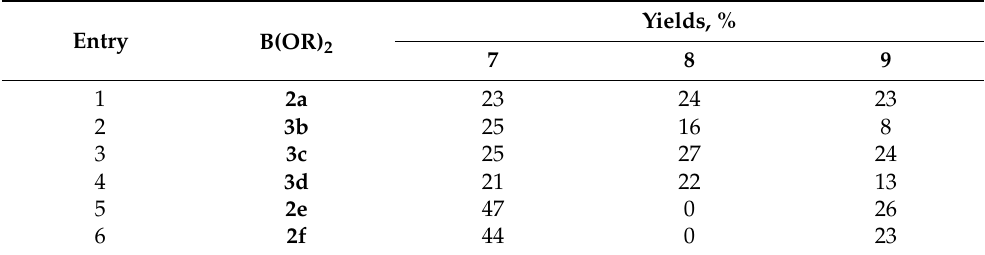
Table 2. Yieldsofcompounds 7–9 intheSuzukicross-couplingreactionsof4,7-dibromobenzo[ d ][1,2,3]thiadiazole 1 with boronic acids 2 and their pinacolate esters 3 .